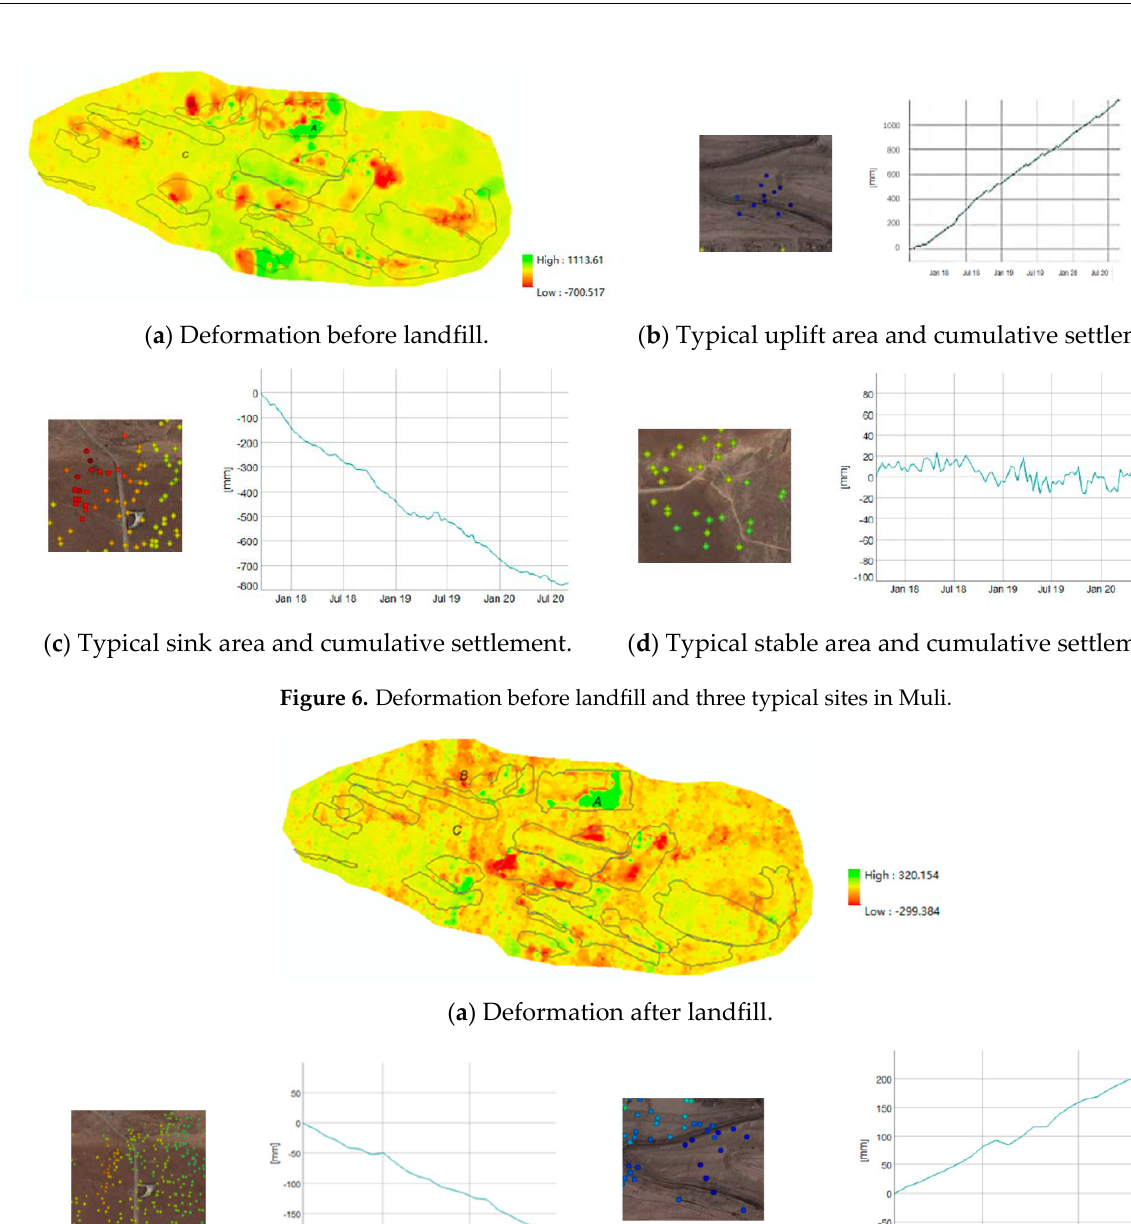
Figure 7. Deformation after landfill and three typical sites in the Muli